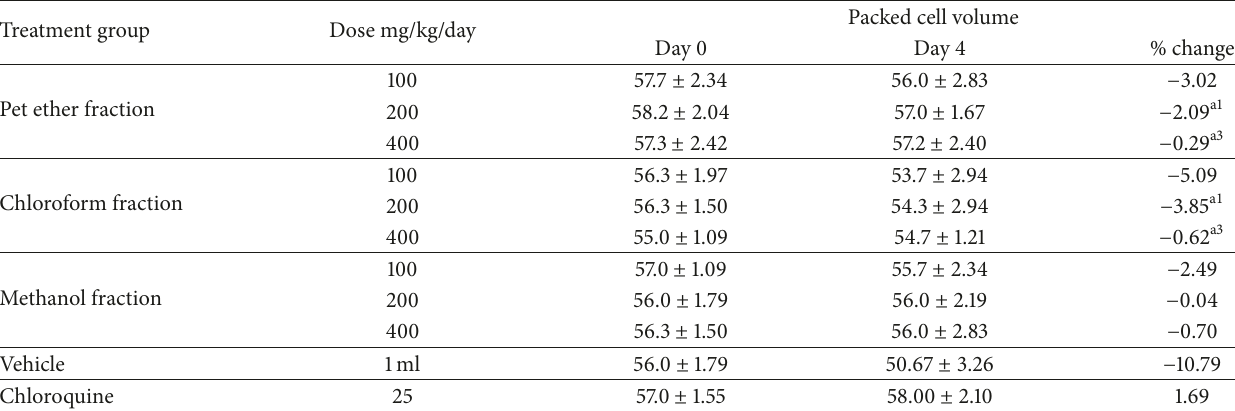
Table 3: Effect of the solvent fractions of Carica papaya rind on packed cell volume (PCV) of P. berghei infected mice on 4-day Peter’s suppression